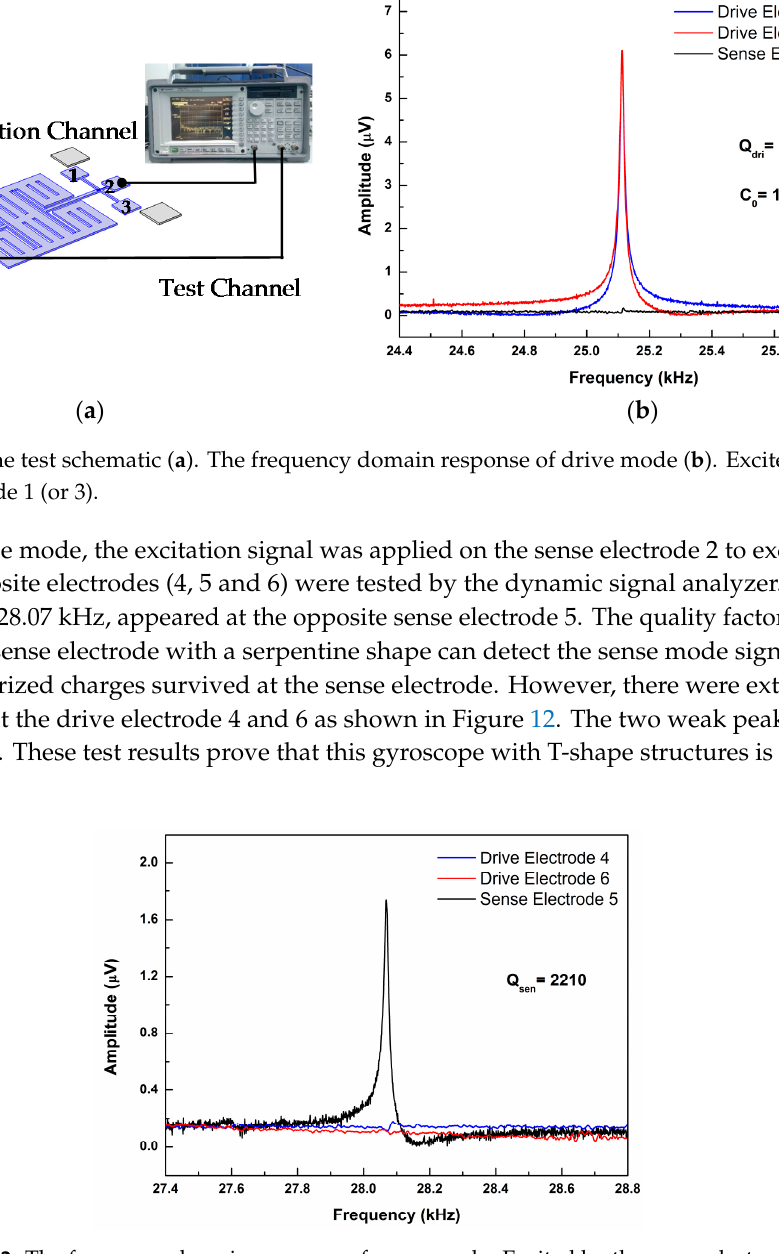
Figure 12. The frequency domain response of sense mode. Excited by the sense electrode 2.